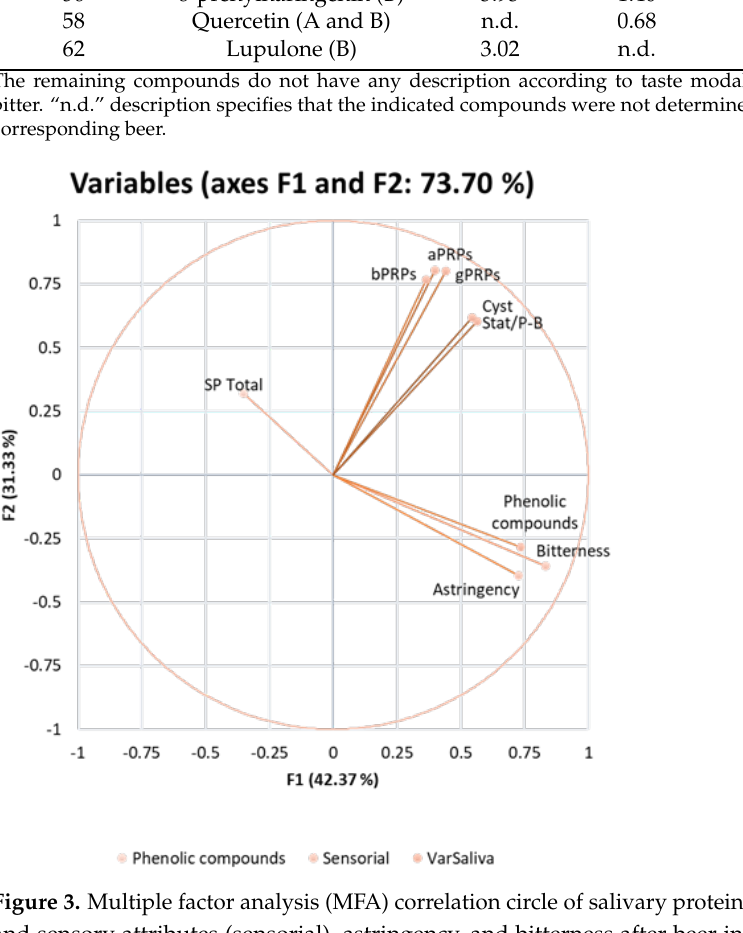
Figure 3. Multiple factor analysis (MFA) correlation circle of salivary proteins, phenolic compounds, and sensory attributes (sensorial), astringency, and bitterness after beer intake. Salivary proteins include bPRPs, gPRPs, aPRPs, statherin, and P-B peptide, cystatins, and total SPs, which comprise the total content of each previous SP family content, upon each beer intake (VarSaliva—variation in saliva).